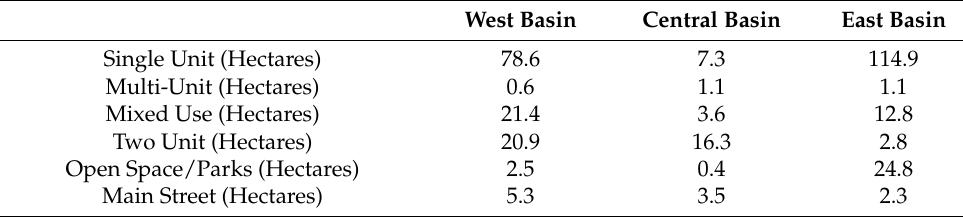
Table 5. Zoning areas by basin and zoning